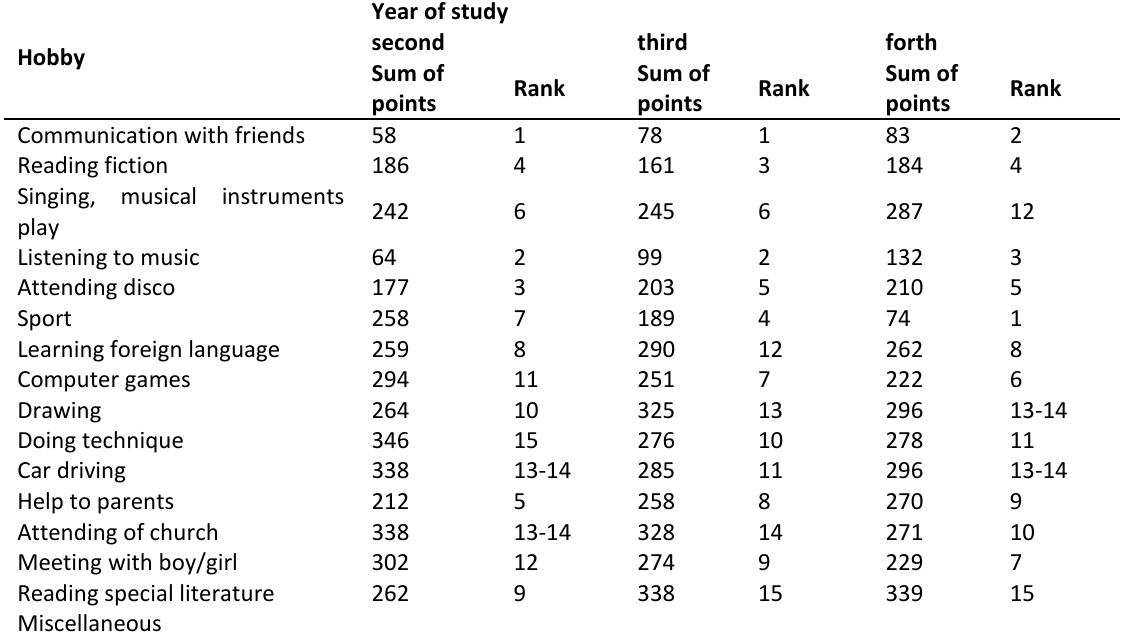
Table 1. Leisure preferences of different years’ pedagogic specialties students